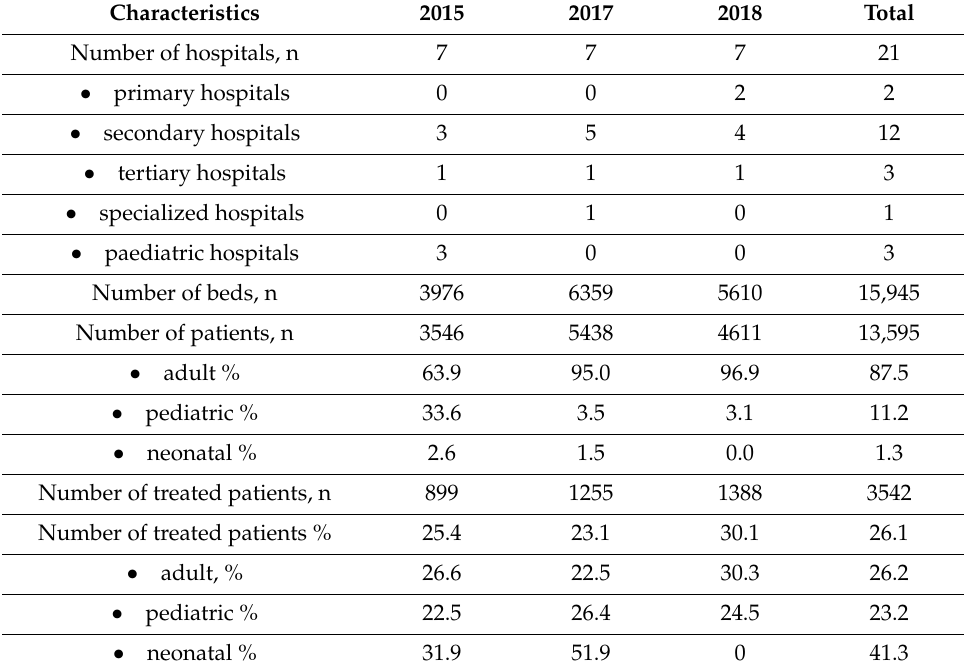
Table 1. Characteristics of the hospitals included in the Global-PPS 2015, 2017 and 2018.